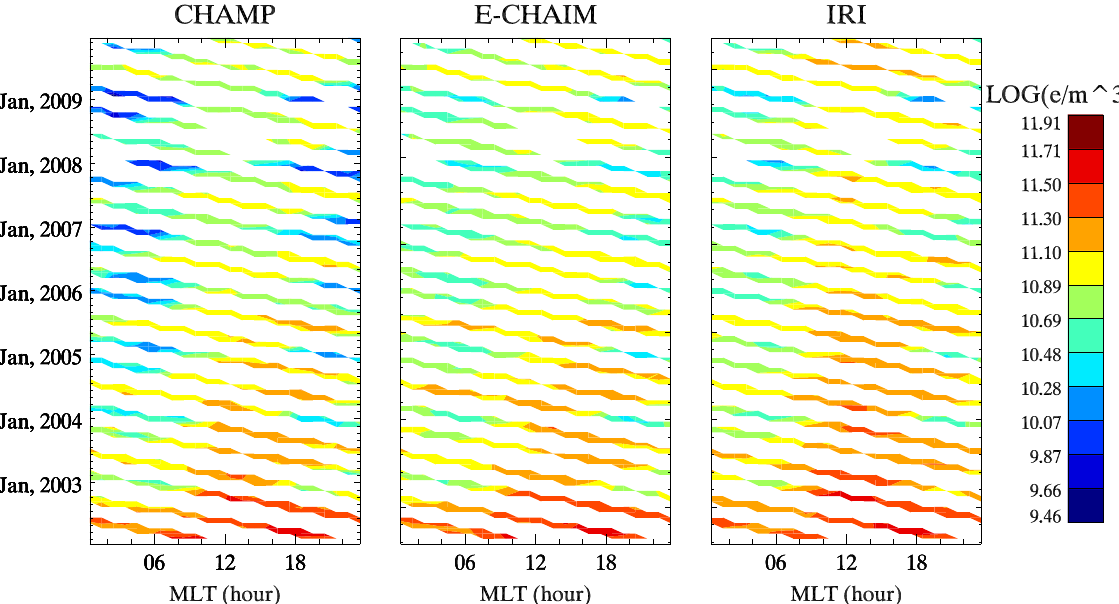
Fig. 13. Log contours of CHAMP (left), E-CHAIM (center), and IRI (right) monthly median electron density at CHAMP orbit altitude from a bin between 55 (cid:1) N and 65 (cid:1) N.